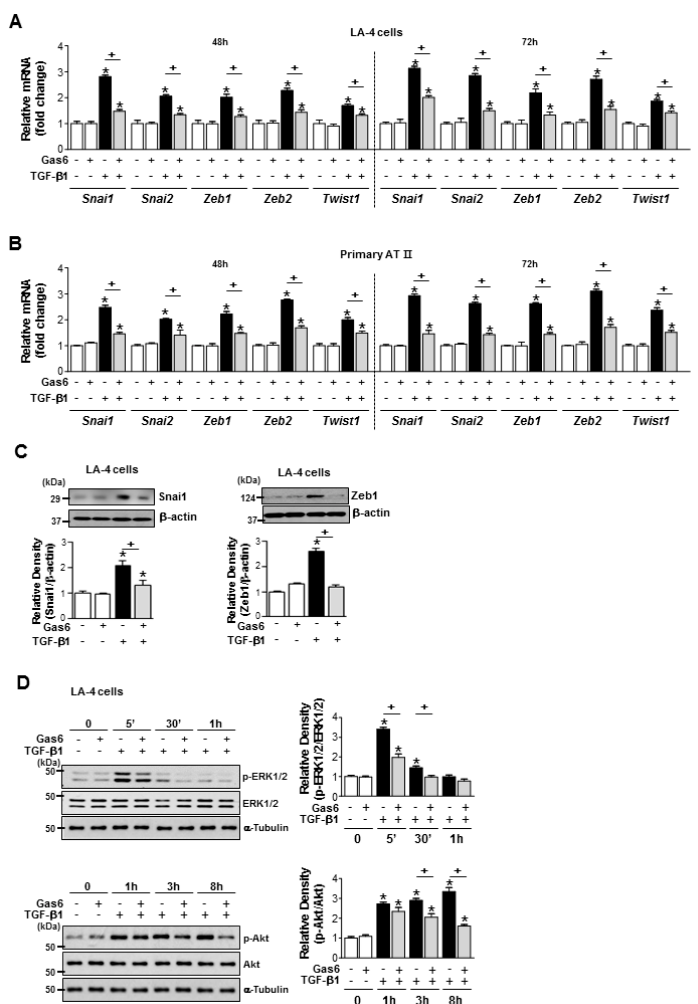
Figure 2. Growth arrest-specific protein 6 (Gas6) pretreatment reduces epithelial-mesenchymal transition (EMT)-regulating transcription factor expression and blocks Smad-independent transforming growth factor (TGF)- β 1 signalling in epithelial cells. ( A – C ) LA-4 and ATII epithelial cells (ECs) were pretreated with 400 ng / mL Gas6 20 h prior to 10 ng / mL TGF- β 1 stimulation for 48 or 72 h. ( A , B ) The amounts of Snai1 / 2, Zeb1 / 2, and Twist1 mRNA were analysed by real-time PCR and normalized to that of hypoxanthine phosphoribosyltransferase ( Hprt ). ( C , D ) Representative immunoblots of LA-4 EC lysates were performed with anti-Snail1, -Zeb1, -total / phosphorylated ERK1 / 2, and -Akt protein antibodies. Beta-actin or alpha-tubulin was used as a loading control. Densitometric analysis of the indicated protein abundances. Data in all bar graphs are the mean ± S.E. of three independent experiments. * P < 0.05 compared with control; + P < 0.05 as